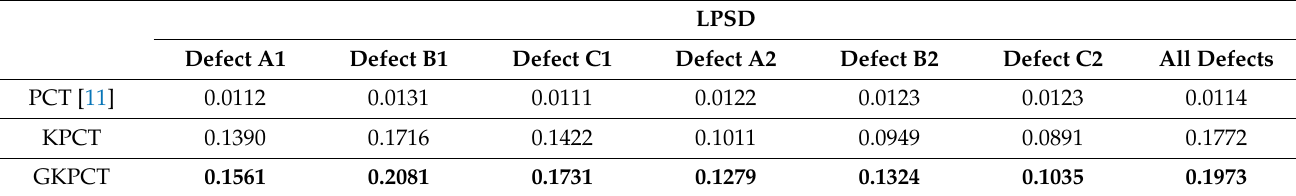
Table 4. LPSD values of different methods for CFRP specimen